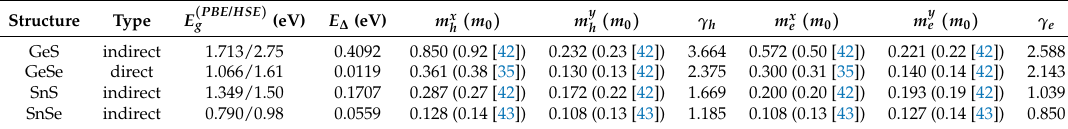
Table 2. Semiconductor type, band gap calculated under PBE and HSE levels, energy difference ( E ∆ ) between CBM and CB1, calculated carrier (holes and electrons) effective mass along the transport directions and the anisotropic ratio γ h , e for holes and electrons of monolayer MX